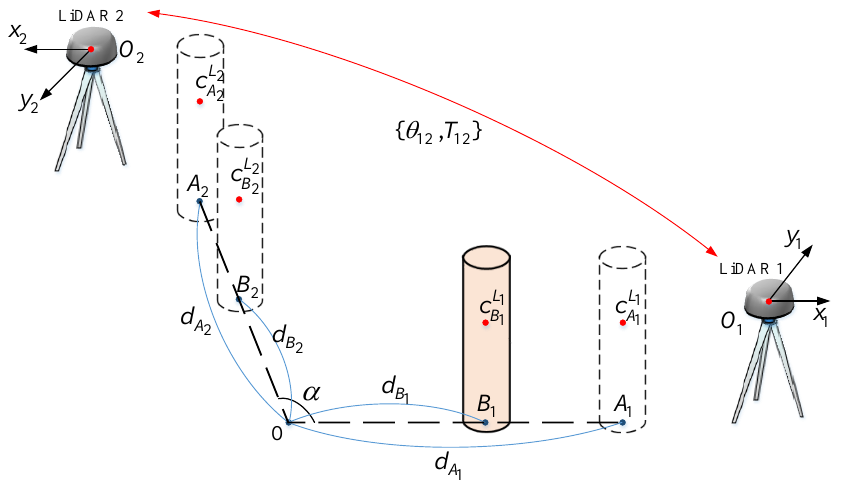
Figure 4. The configuration of LiDARs